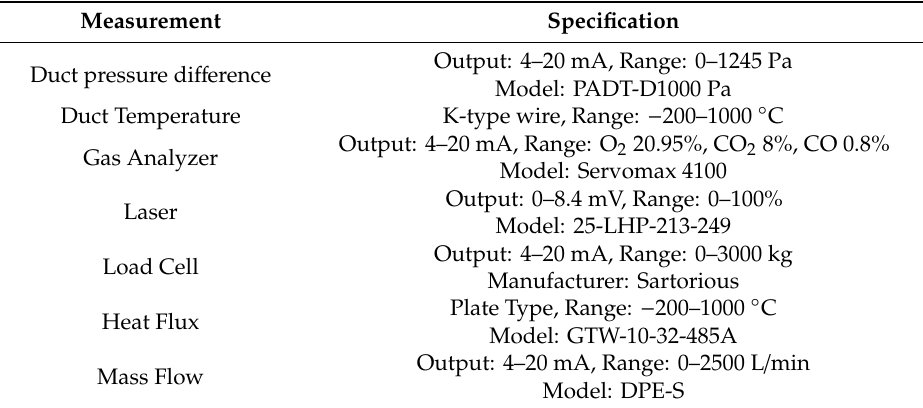
Figure 2. Schematic diagram of large-scale calorimeter (LSC) used to detect the changes in the heat release rate and toxic substances as a function of time. Table 1. Specification of experimental apparatus.